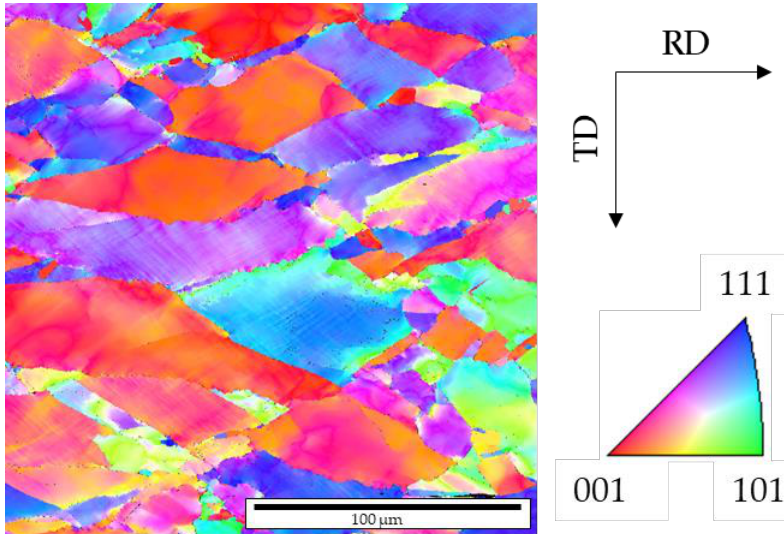
Figure 1. Electron backscatter diffraction inverse pole figure (EBSD-IPF) map of hot-rolled Fe-23Mn-0.3C-1Al steel. The IPF takes the rolling direction (RD) as reference axis.